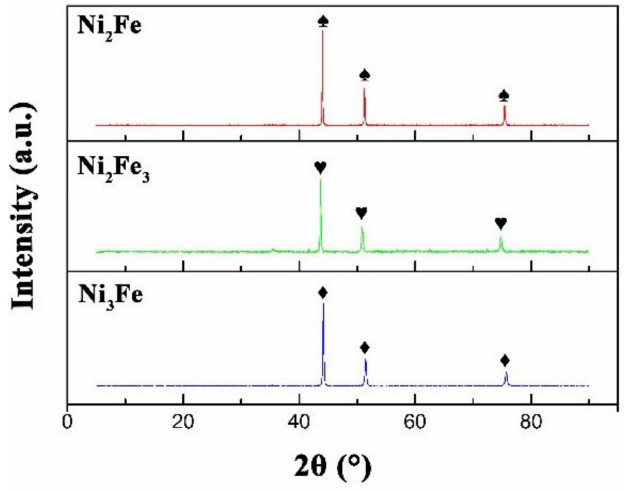
Figure 3. XRD analysis of prepared